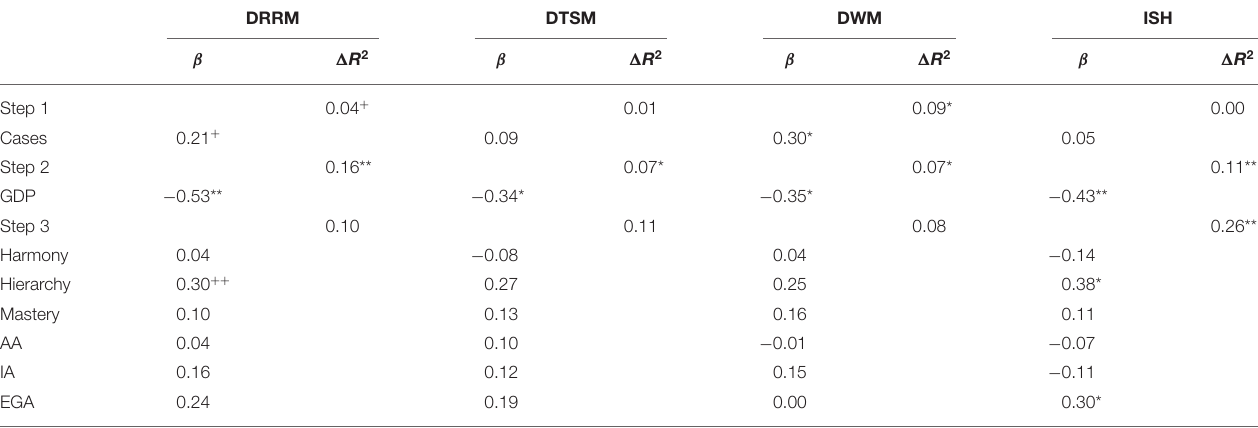
TABLE 3 | Model summary of sequential regression analysis examining relationships between cultural value orientations and mobility changes in the Covid-19 pandemic after controlling for total cases and